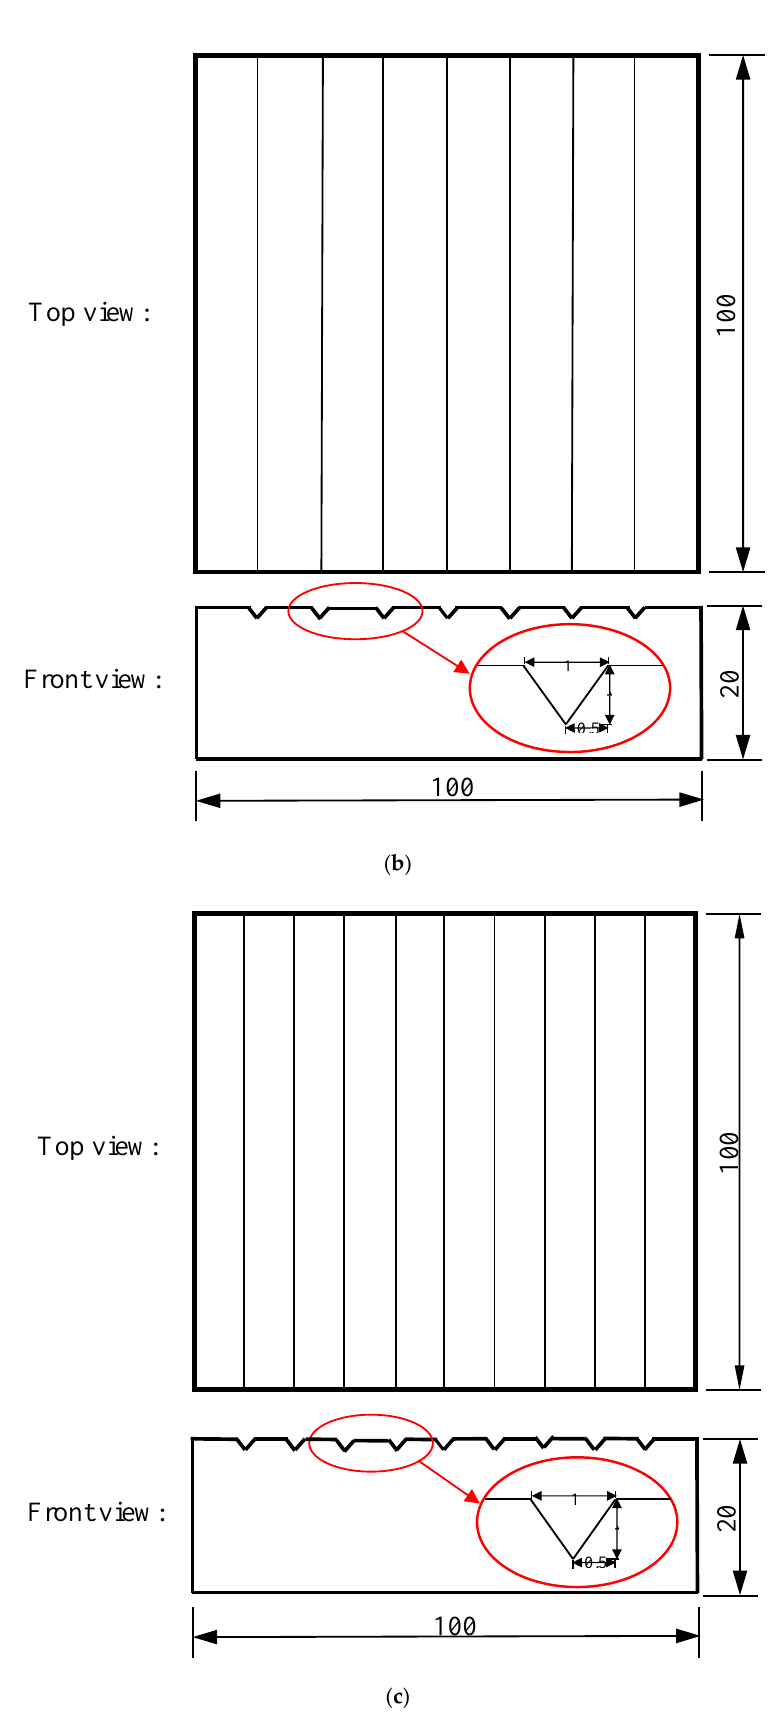
Figure 4. The roughness design for the concrete plate surface (unit: mm): ( a ) zero grooves; ( b ) seven grooves; ( c ) nine